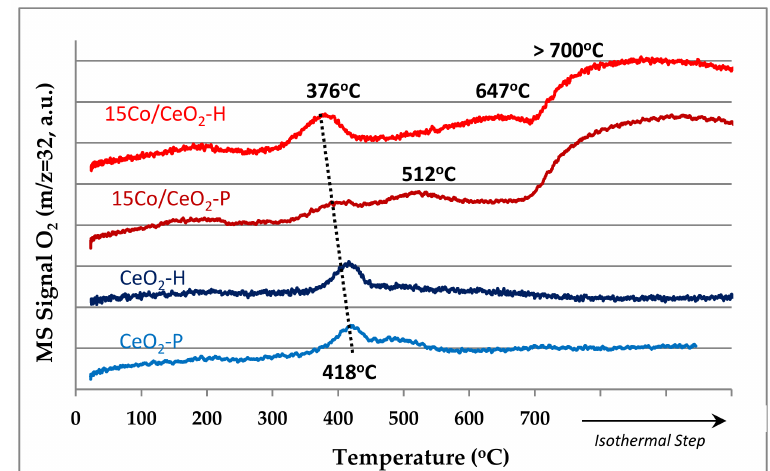
Figure 5. O 2 -TPD profiles of the two bare CeO 2 supports (prepared with either the precipitation or the hydrothermal method) and the corresponding 15 wt.% Co/CeO 2 supported